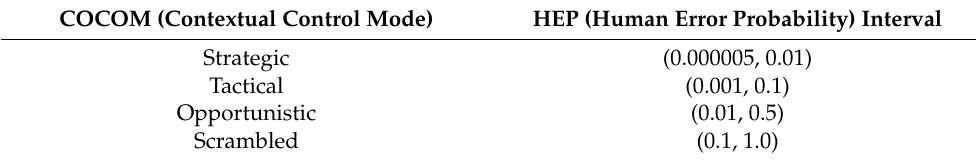
Table 2. The COCOMs and their human error probability (HEP)